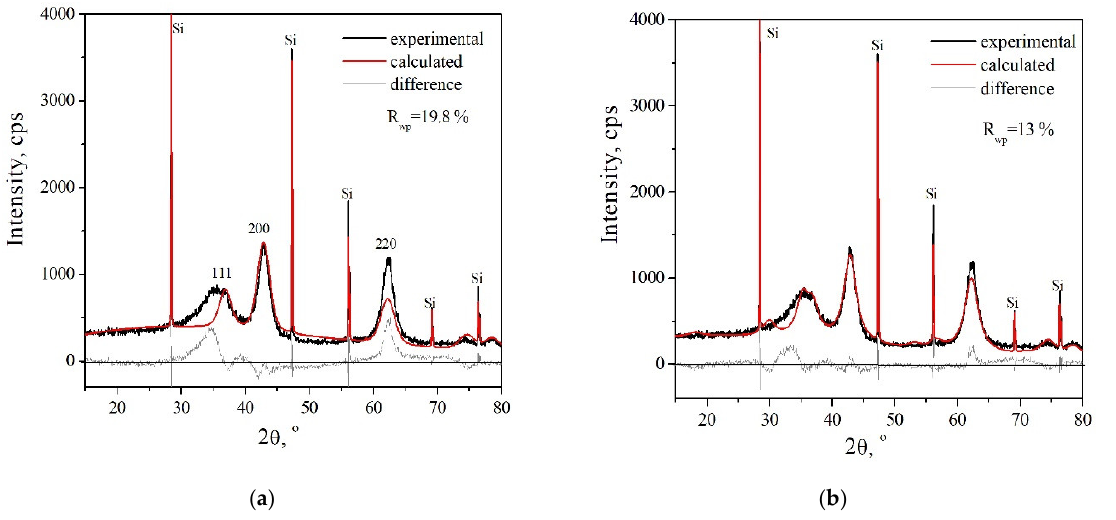
Figure 6. Rietveld refinement in Fm3m space group in the frame of NaCl structure ( a ) and in Fd3m space group of spinel ( b ) for the MgGa oxide.